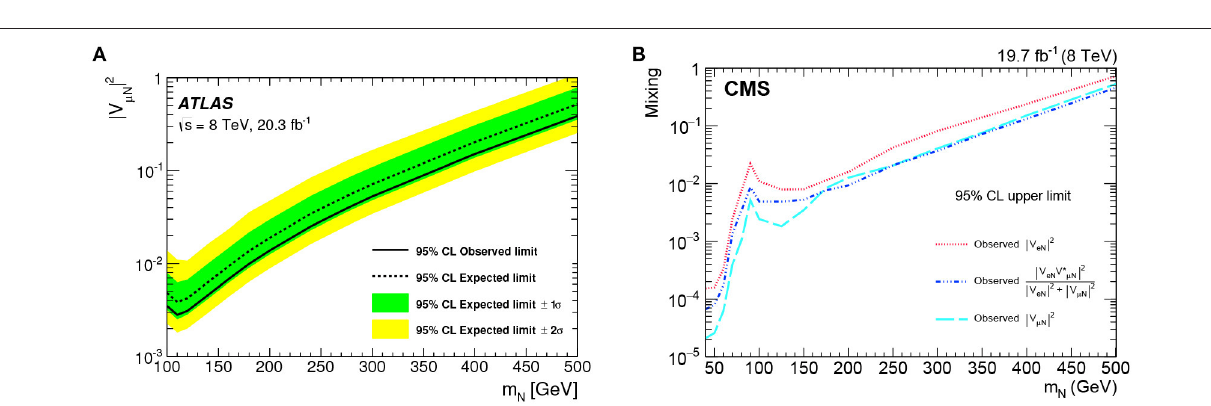
2 from searches for pp V ℓ N | |